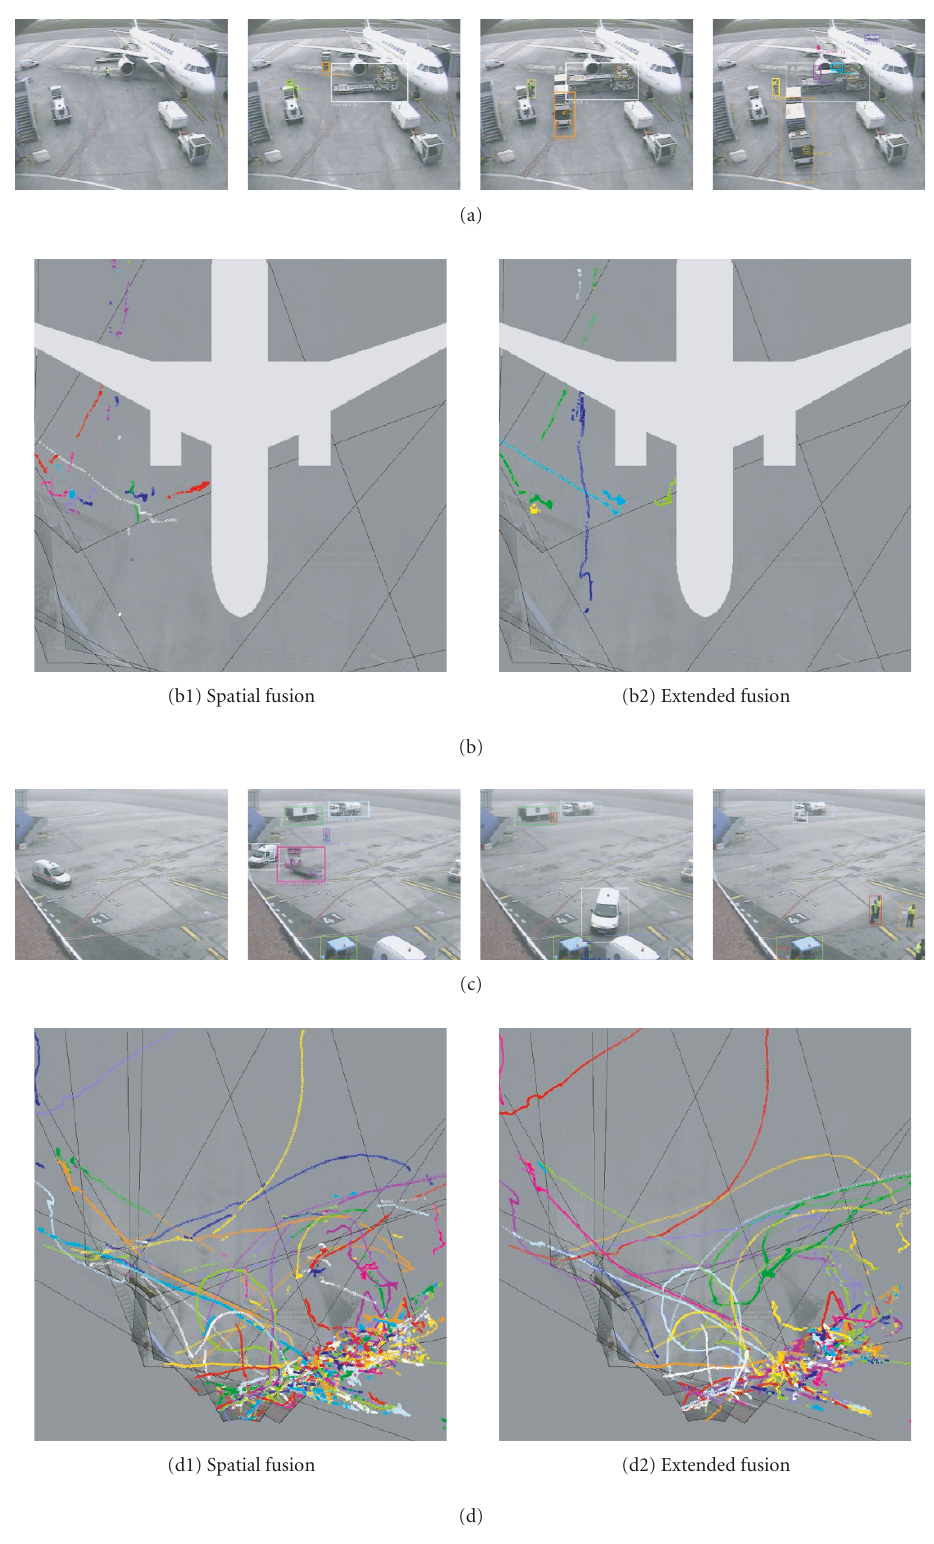
Figure 18: Results of the data fusion module showing tracked object locations on the ground plane for two representative datasets. The track colour is derived from the object ID, limited to eight colours for visualisation. (a) S28-all cameras frames: 0, 500, 750, 1000. (b) Objects tracked by the data fusion module with (extended fusion) and without (spatial fusion) the extended validation gate and confidence-based fusion. The aircraft is added for illustrative purposes. (c) S21-All cameras frames: 0, 6000, 7000, 9000. (d) Objects tracked by the data fusion module with (extended fusion) and without (spatial fusion) the extended validation gate and confidence-based